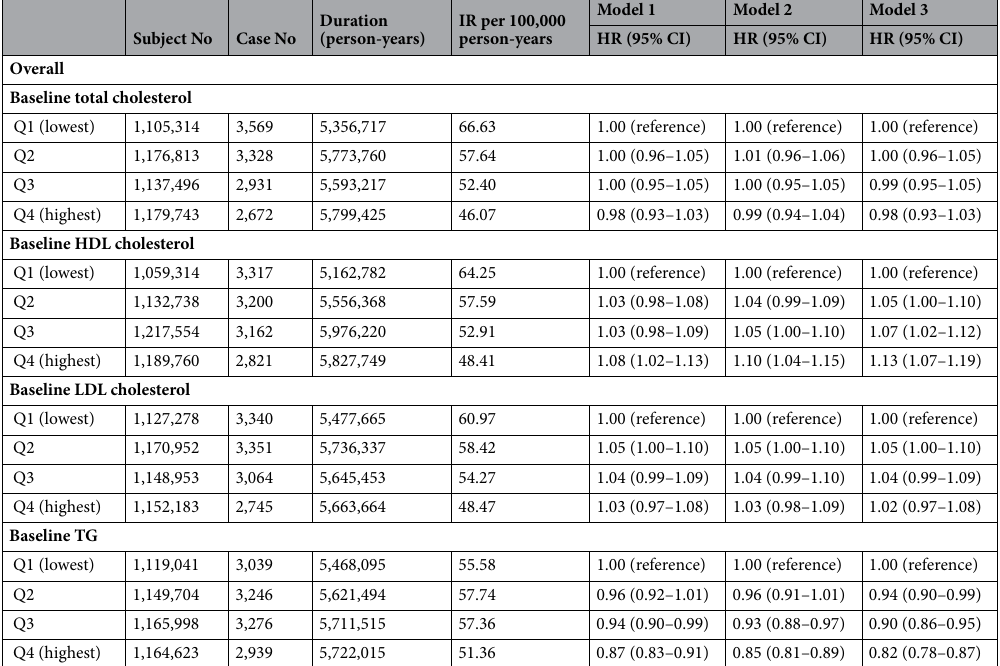
Table 3. Hazard ratios and 95% confidence intervals for development of exudative age-related macular degeneration according to baseline lipid profile (sensitivity analysis excluding subjects taking lipid-lowering medication at baseline). IR incidence rate, HR hazard ratio, CI confidence interval, Q quartile, HDL high- density lipoprotein, LDL low-density lipoprotein, TG triglycerides. Model 1: adjusted for age and sex. Model 2: adjusted for demographic factors (age, sex, income level), and systemic comorbidities (hypertension, diabetes mellitus, stroke, heart disease, chronic kidney disease, and dyslipidemia medication). Model 3: adjusted for demographic factors, systemic comorbidities, and behavioral factors (smoking history, drinking habits, physical activity, and body mass